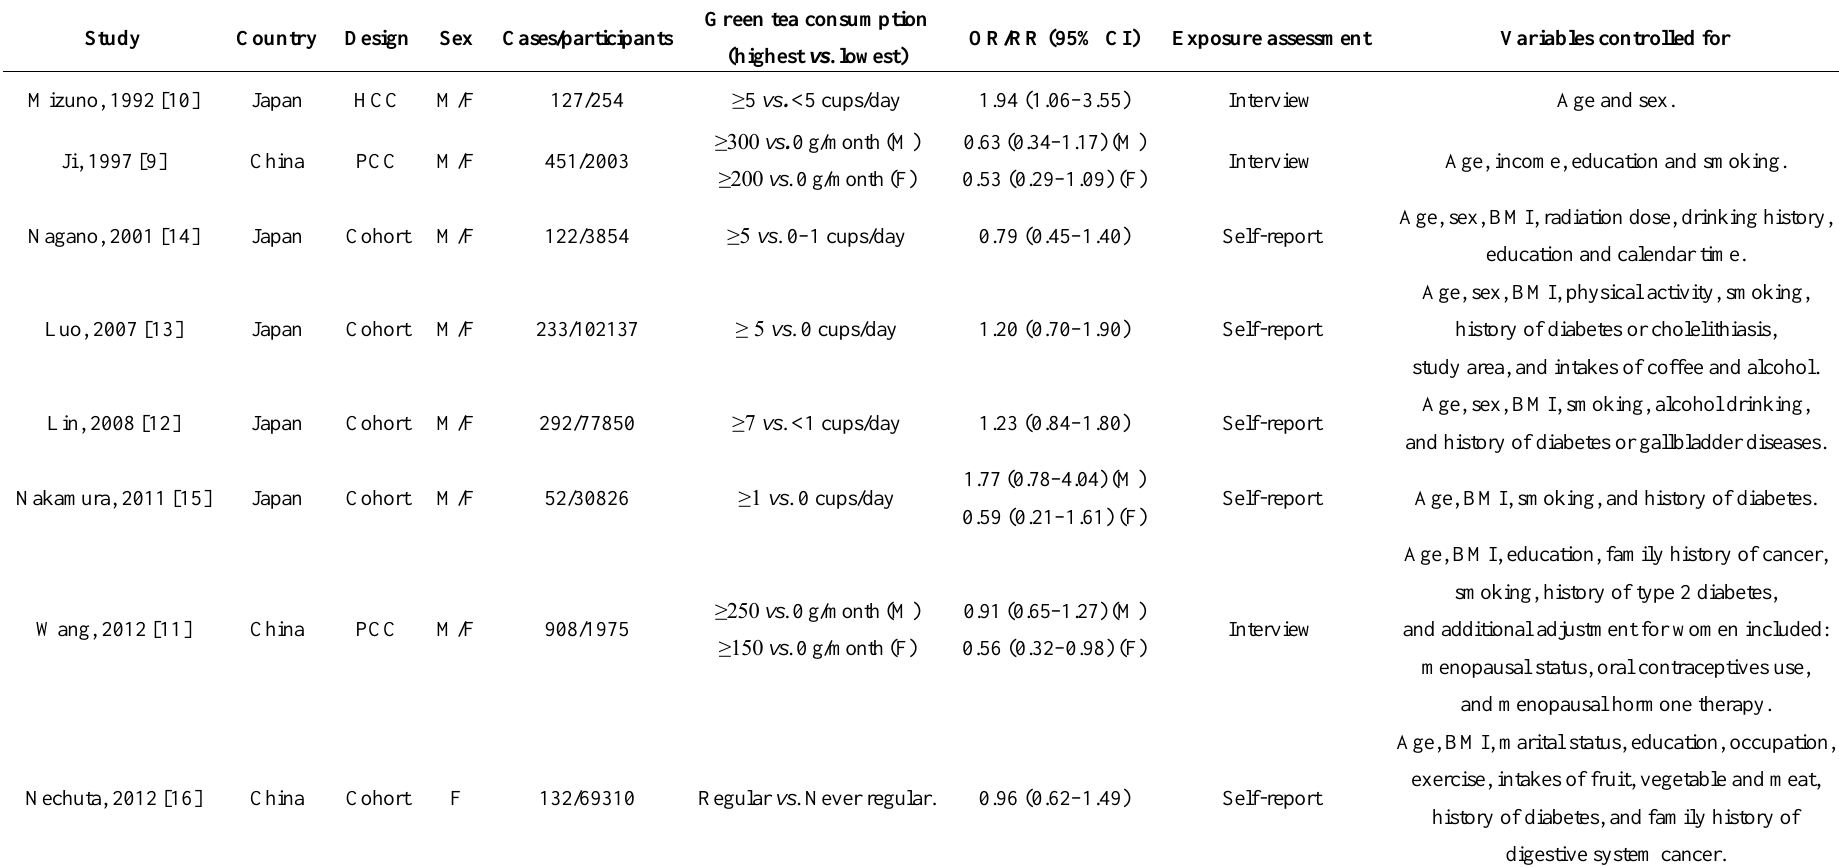
Table 1. Characteristics of published case-control and cohort studies on green tea consumption and pancreatic